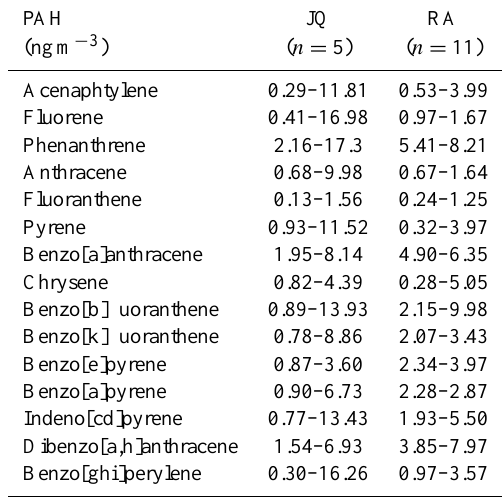
Table 3. Particle phase PAH concentration ranges in the JQ and RA